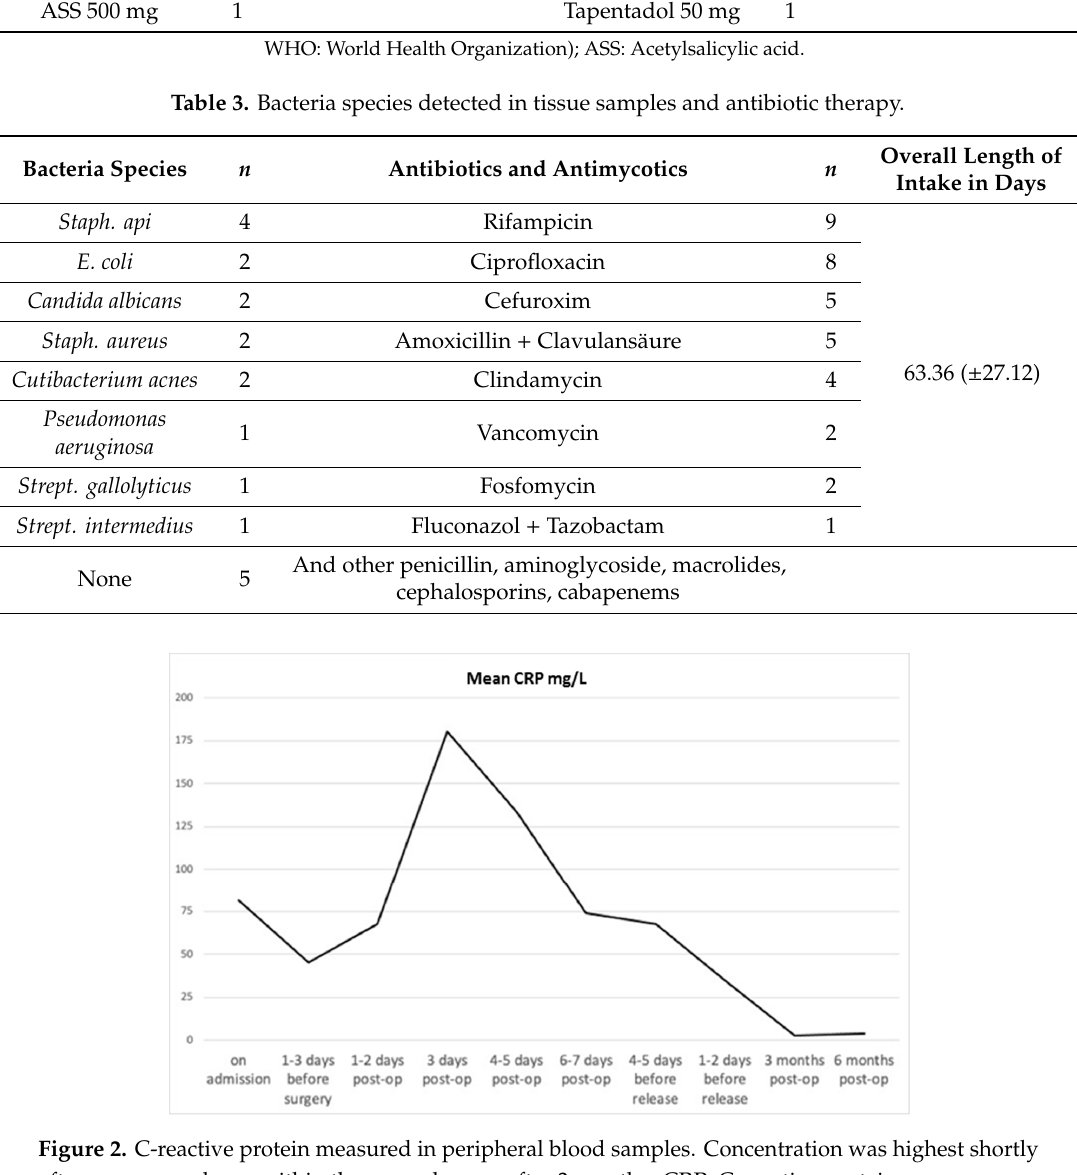
Table 1. Patients’ clinical data (mean values and standard deviations are shown).